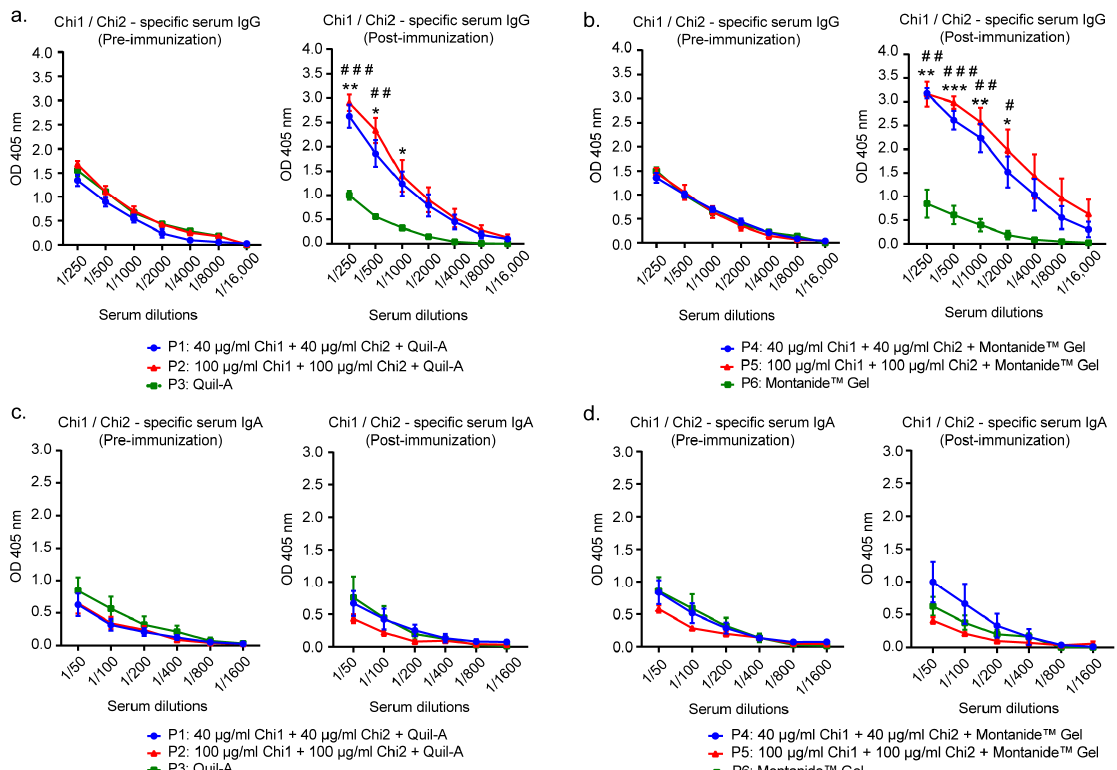
Figure 2. Serum antibody response in cows immunized with the vaccine formulations. Sera obtained before the first immunization and after the last immunization were used for the determination of anti ‐ Chi1/Chi2 IgG and IgA antibodies. Samples were analyzed in duplicate, and the results are expressed as means ± SEM of absorbance values at 405 nm for each serum dilution, n = 5 animals per group. Anti ‐ Chi1/Chi2 IgG ( a ) and IgA ( c ) antibodies from P1, P2 and P3 groups. Anti ‐ Chi1/Chi2 IgG ( b ) and IgA ( d ) antibodies from P4, P5 and P6 groups. Statistical analysis was performed using a two ‐ way ANOVA, followed by Tukey’s multiple comparison test. p < 0.05 was considered signif ‐ icant. Asterisks (*) indicate significant differences between the group immunized with the formula ‐ tion containing 40 μ g of each chimeric protein and the control group. * p < 0.05, ** p < 0.005, *** p < 0.0005. Number signs (#) indicate significant differences between the group immunized with the formulation containing 100 μ g of each chimeric protein and the control group. # p < 0.05, ## p < 0.005, ### p < 0.0005.